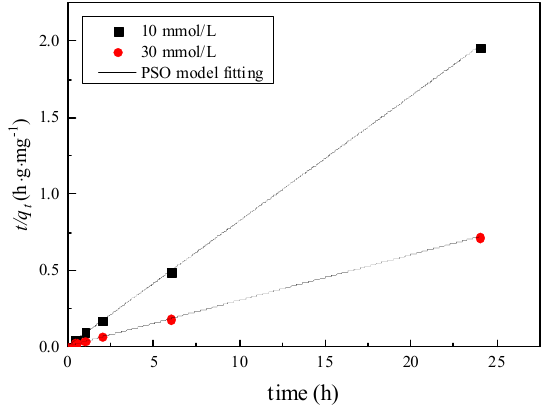
Figure 6. Pseudo first order model.